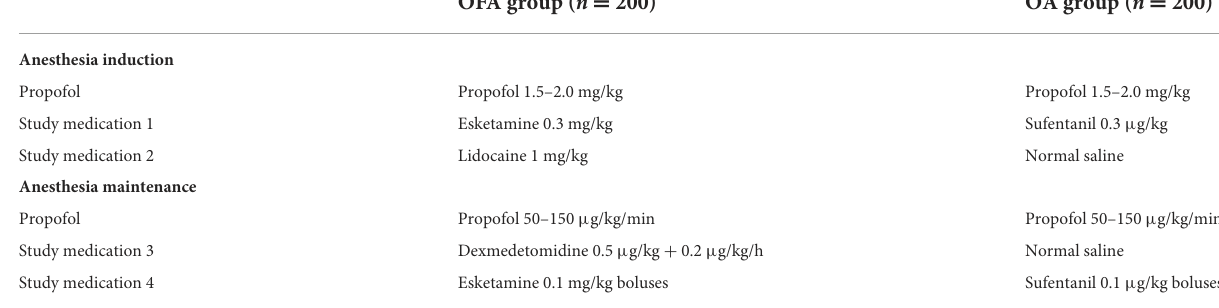
TABLE 2 Details of study